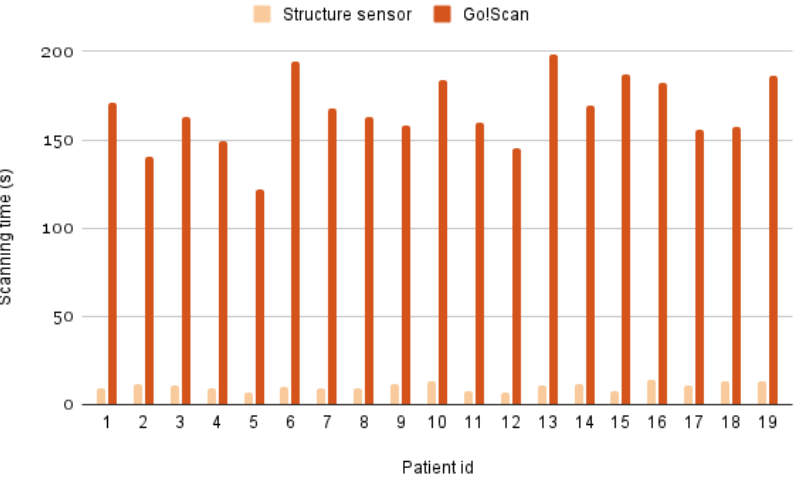
Figure 17. Scanning time taken using the Structure Sensor and the Go!Scan for each patient.